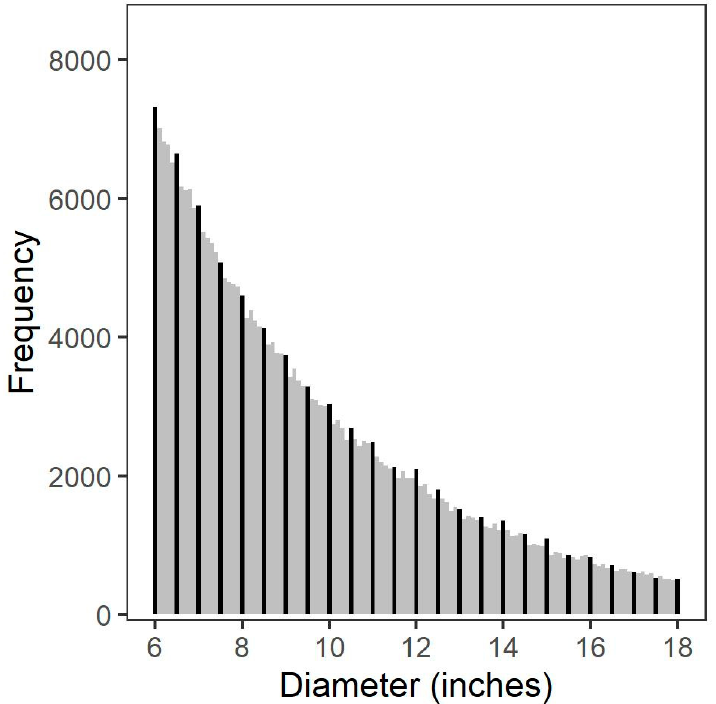
Figure 3. Diameter distribution for an exemplary subset of tree-sized stems. Darkest bars indicate values ending with the digit zero or five. Table 3. Estimated coefficients (and standard errors) for the model 𝑙𝑜𝑔𝑖𝑡(cid:4666)𝜋(cid:4667) = 𝛼+𝛽 𝑥 ⋯ + 𝛽 predicting the probability that diameter ends with the digit 0 or 5 by region. (cid:2876) (cid:2876)